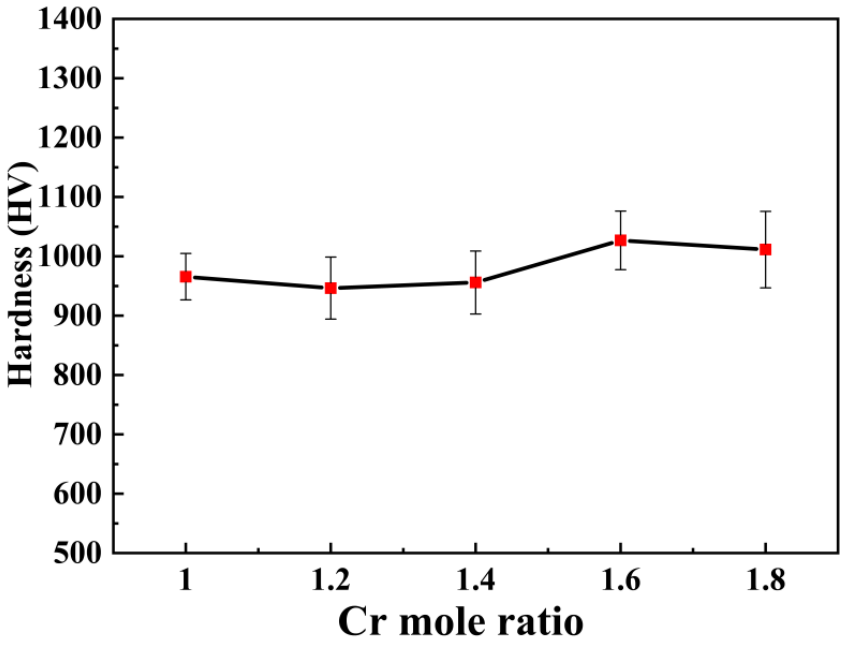
Figure 5. Hardness of AlSi 0.5 Cr x Co 0.2 Ni (x = 1.0, 1.2, 1.4, 1.6, and 1.8) high entropy alloys.